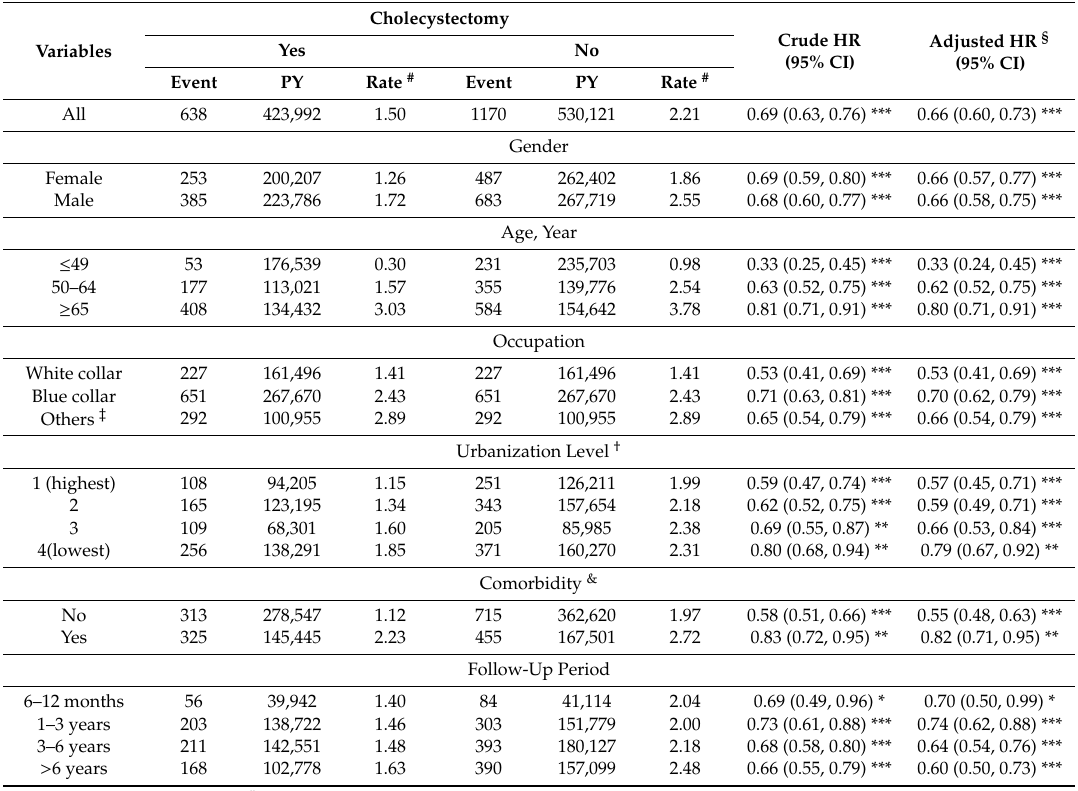
Table 3. The comparison of the colon cancer incidence densities after 6 months of the follow-up period between gallbladder stones patients with and without cholecystectomy, stratified by demographic characteristics and the presence or absence of a